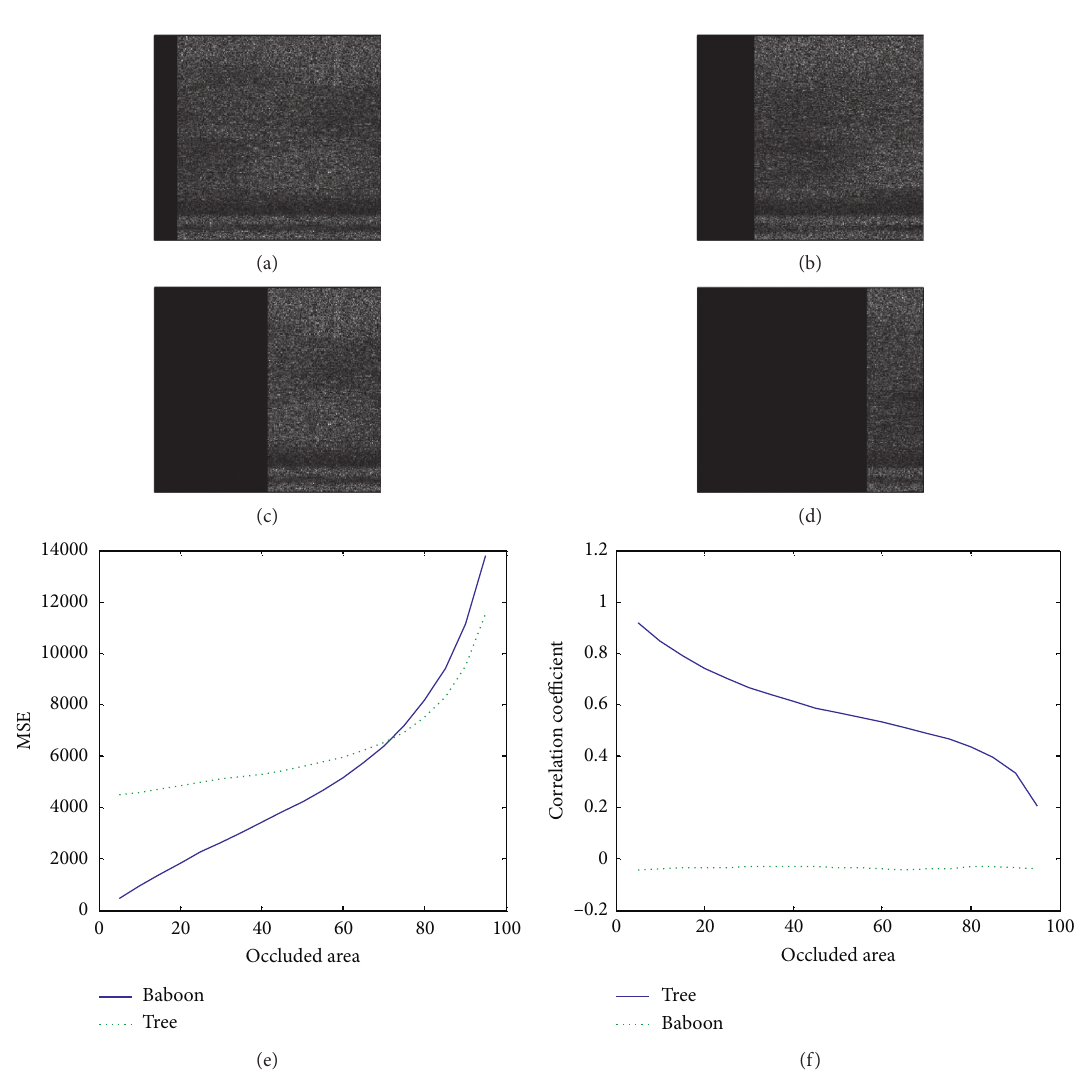
Figure 11: Occlusion results to the grayscale images of varying degrees of occlusion. (a) For 10% occlusion of the encrypted image. (b) For 25% occlusion of the encrypted image. (c) For 50% occlusion of the encrypted image. (d) For 75% occlusion of the encrypted image; (e) MSE plot with the percentage of the occluded area; (f) CC plot with the percentage of occluded area.